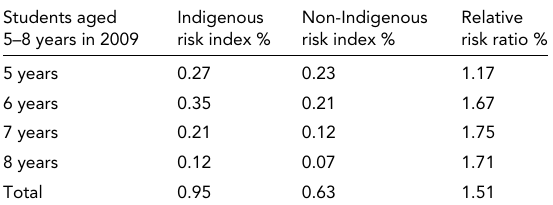
Relative Risk Ratios Calculated From the Risk Ratios of Both Indigenous and Non-Indigenous Repeated Students Aged 5 to